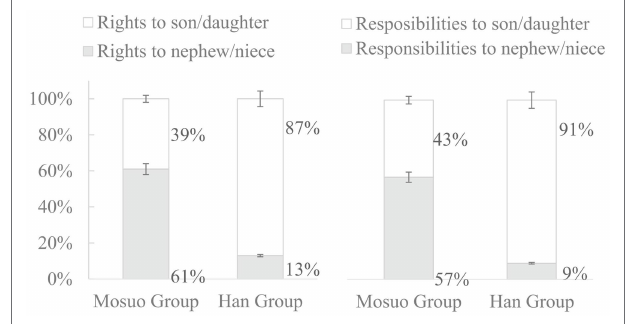
FIGURE 2 | Adult participants’ average percentage of the choice on the rights and responsibilities in Study 2. Error bars represent 95%